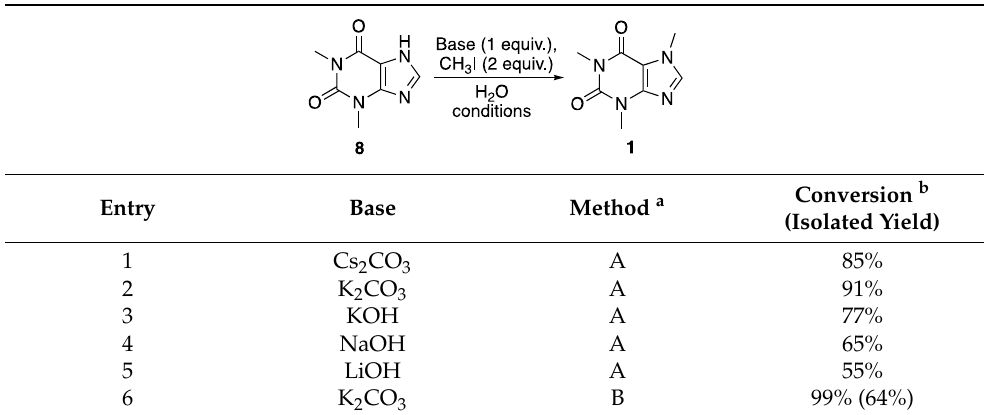
Table 1. Optimization of the reaction conditions.